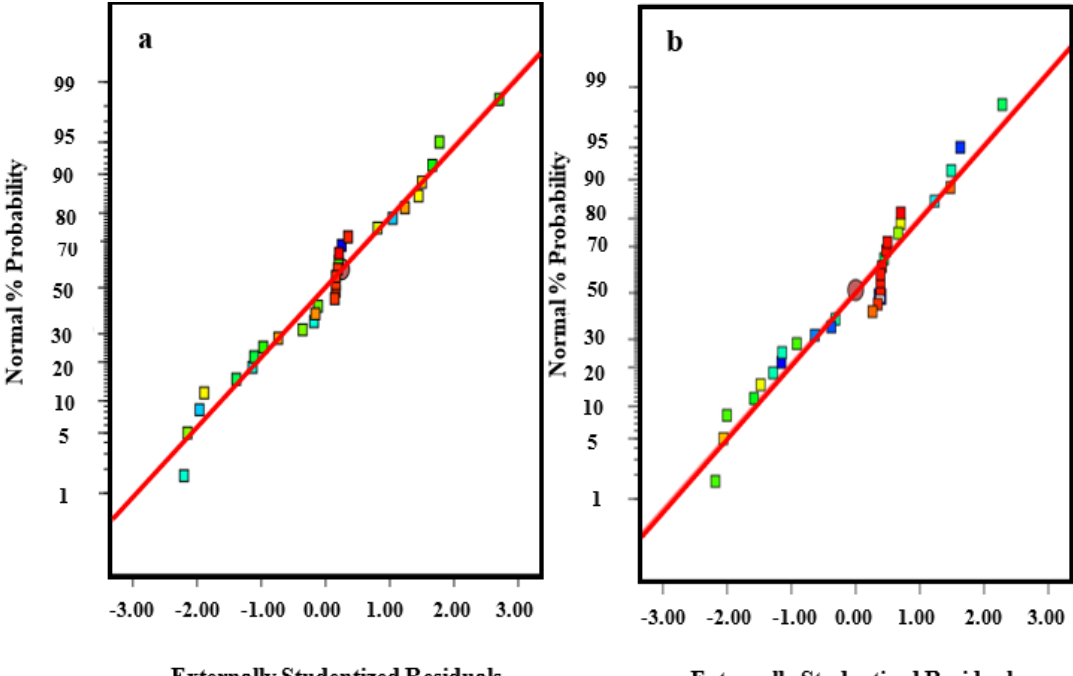
Figure 5. Normal percentage probability plot of residuals for ( a ) PAHs removal and ( b ) COD removal.